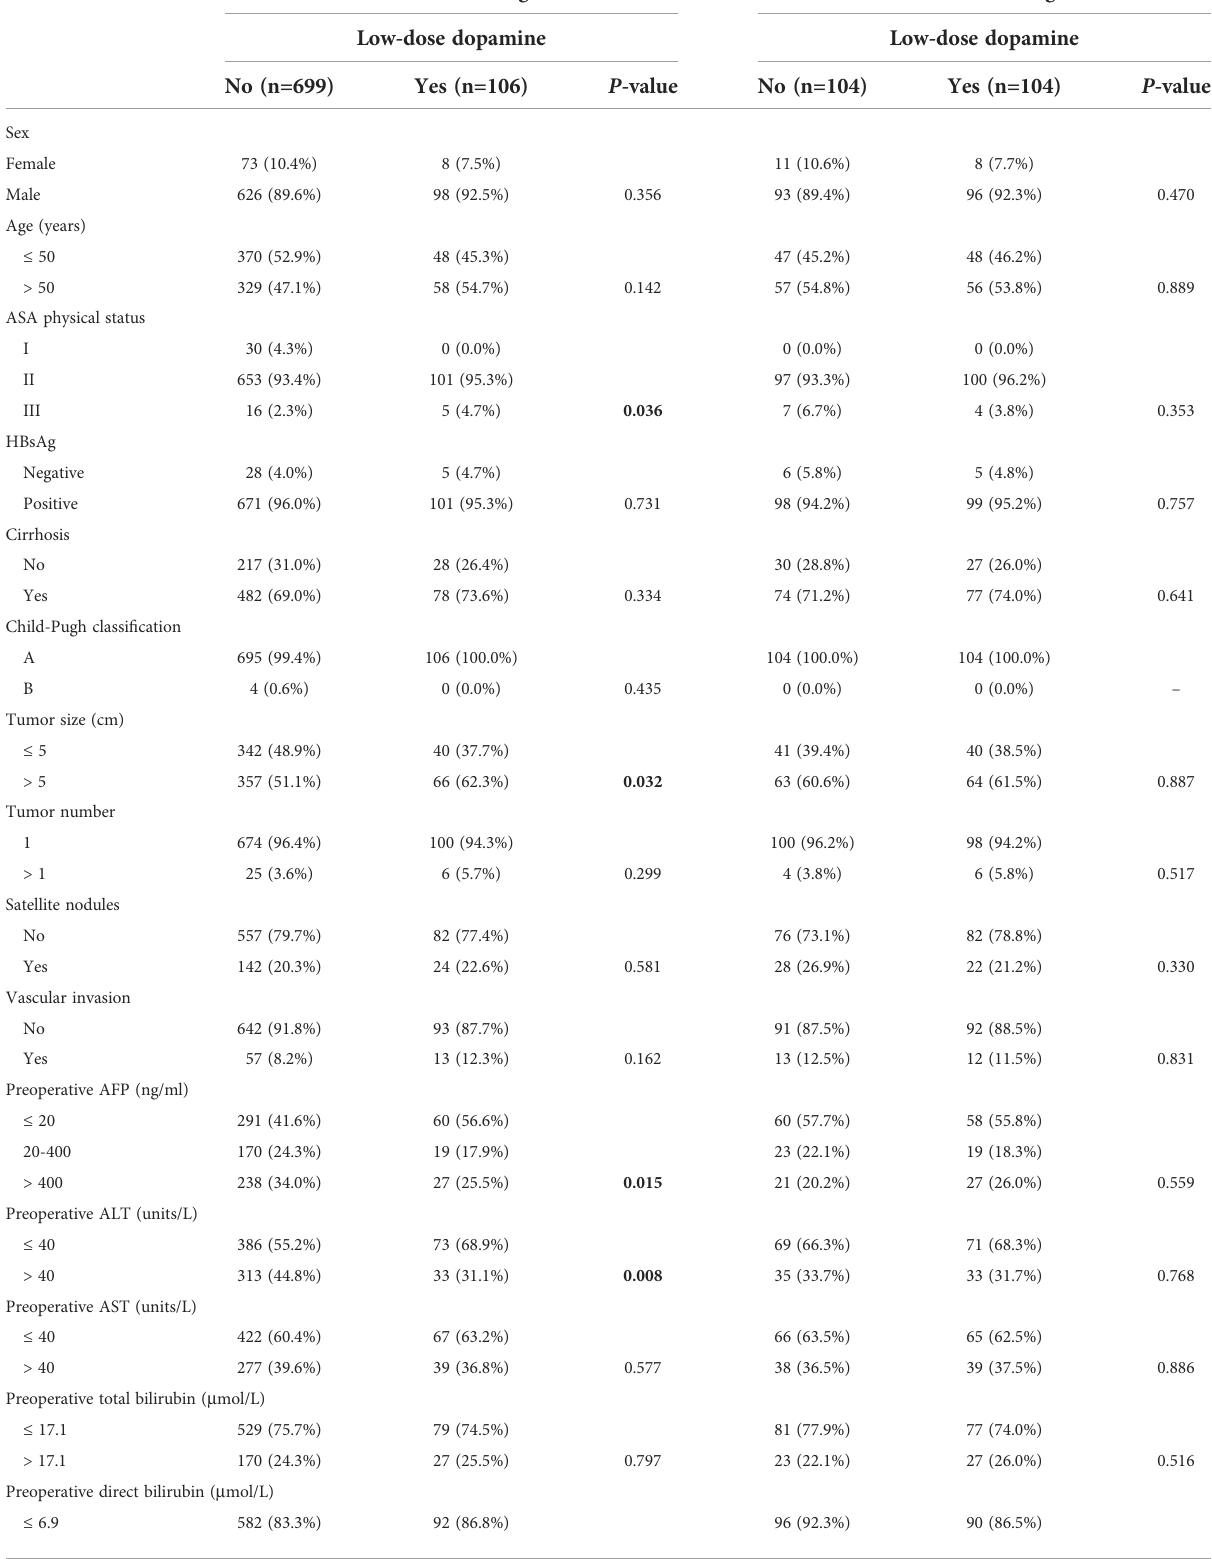
TABLE 1 Patient characteristics with low-dose dopamine administered before and after propensity score matching.